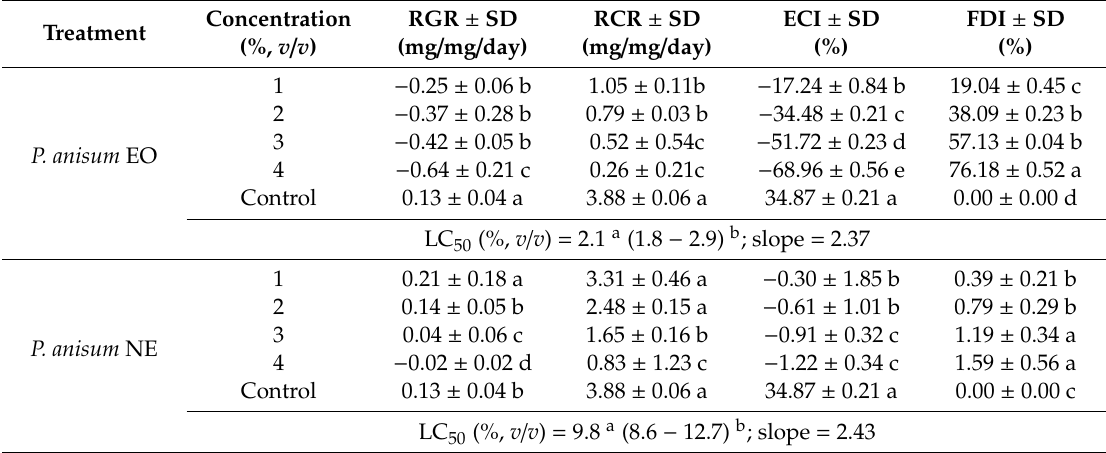
Table 2. Variation of nutritional indices in Tribolium castaneum treated with di ff erent concentrations of Pimpinella anisum essential oil and nanoemulsion during 4